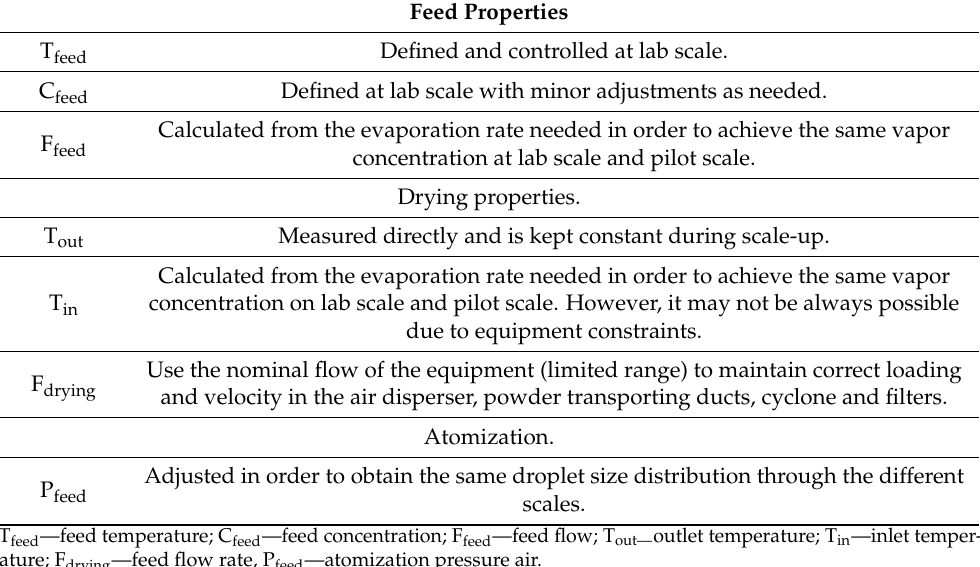
Table 4. Summary of the scale-up methodology regarding process